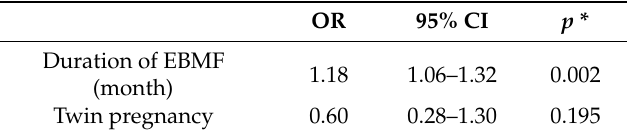
Table 5. Results of logistic regression analysis predicting feeding directly at the